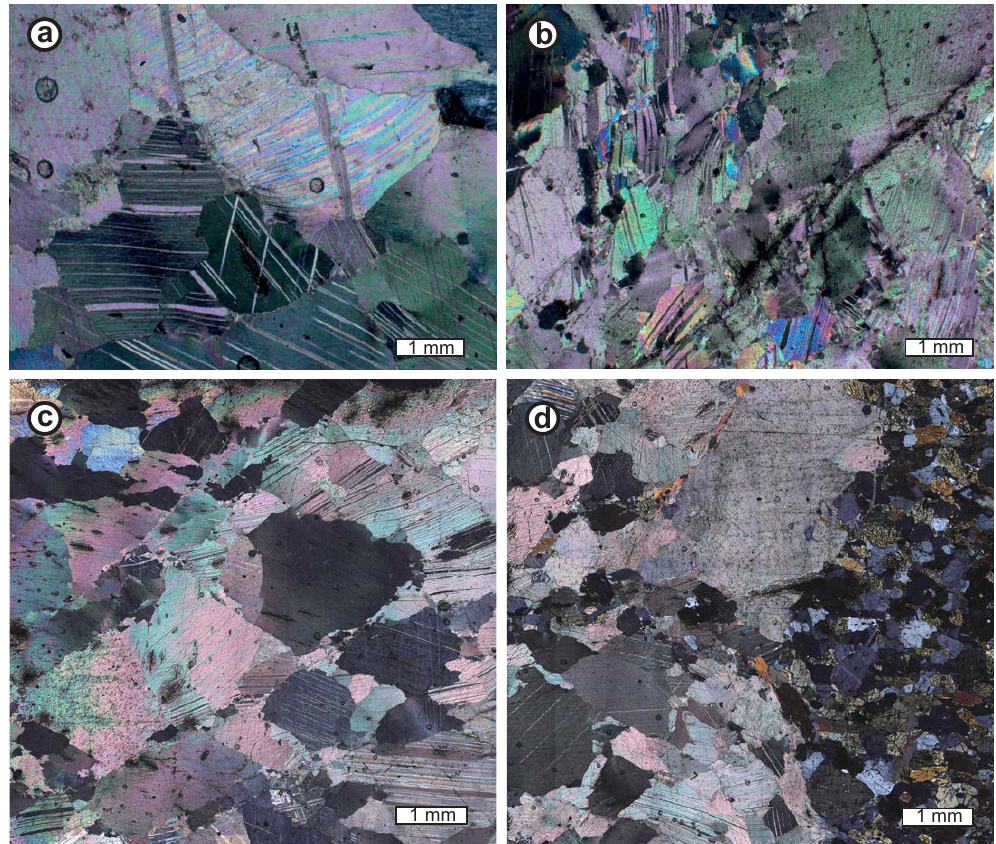
Figure 8. Micrographs of polished marble sections (thickness ∼ 10–15µm, cross-polarized light) illustrating the marble microstructure: (a) the marble shows heterogeneous grain size, locally exceeding 10mm. Extensive twinning indicates late low-temperature deformation. (b) Top-left to bottom-right trending cluster of small-scale shear zones in the marble associated with domino boudinage (compare Fig. 12). In the shear zone the grain size is strongly reduced. Adjacent calcite grains show undulose extinction. (c) Orientation families with similar extinction behaviour are relicts of dynamically recrystallized larger grains. Lobate grain boundaries indicate high-temperature grain boundary migration. (d) Amphibole and plagioclase grains originating from the amphibolite on the right are intermingled with calcite grains in the neck of a pinch-and-swell